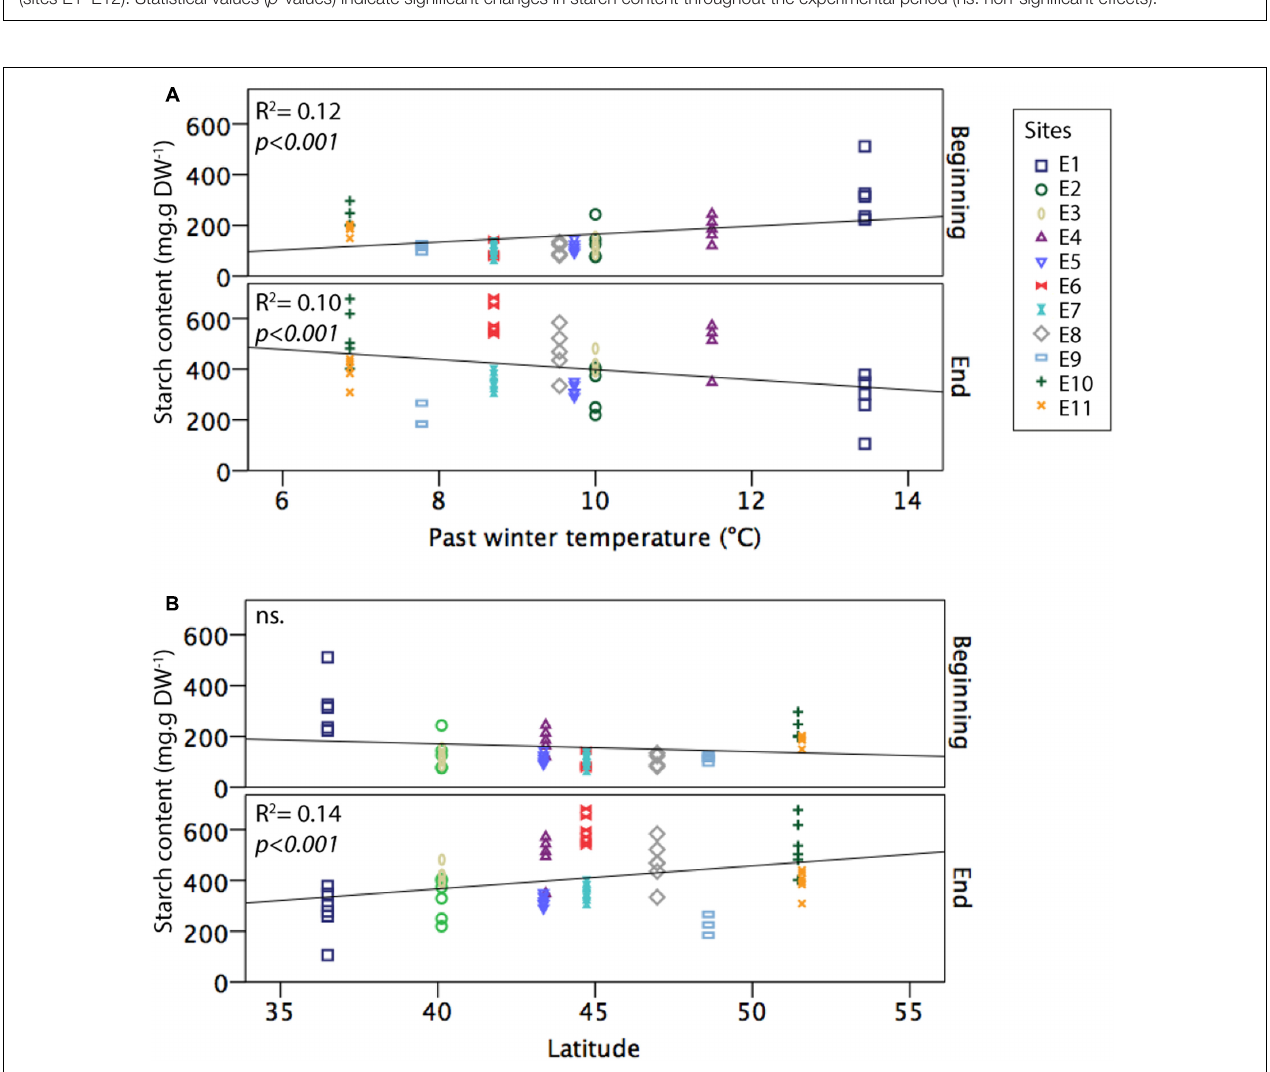
FIGURE 3 | Influence of past winter temperatures (A) and latitude (B) on Z. noltei starch content at the beginning and end of the growing season along the Western European latitudinal gradient (sites E1–E12).